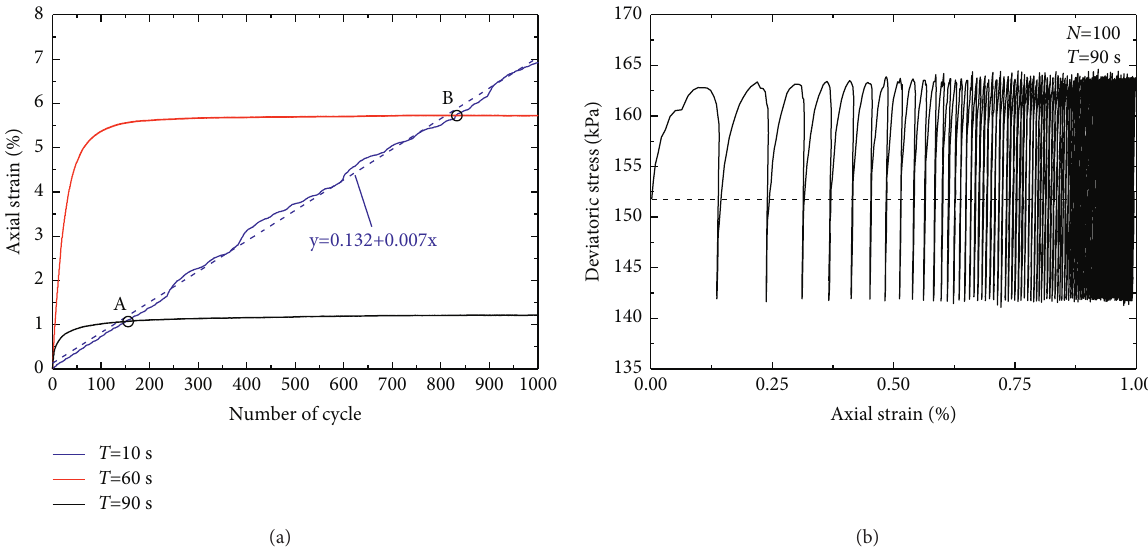
Figure 12: Effect of the number of cycles on sliding zone soil at σ (b) curve deviator stress versus axial strain under N � 100.